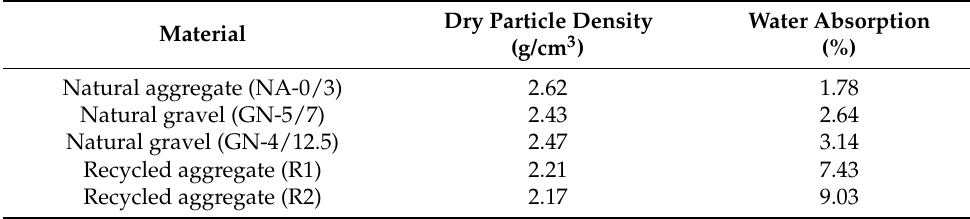
Table 1. Dry particle density and water absorption.